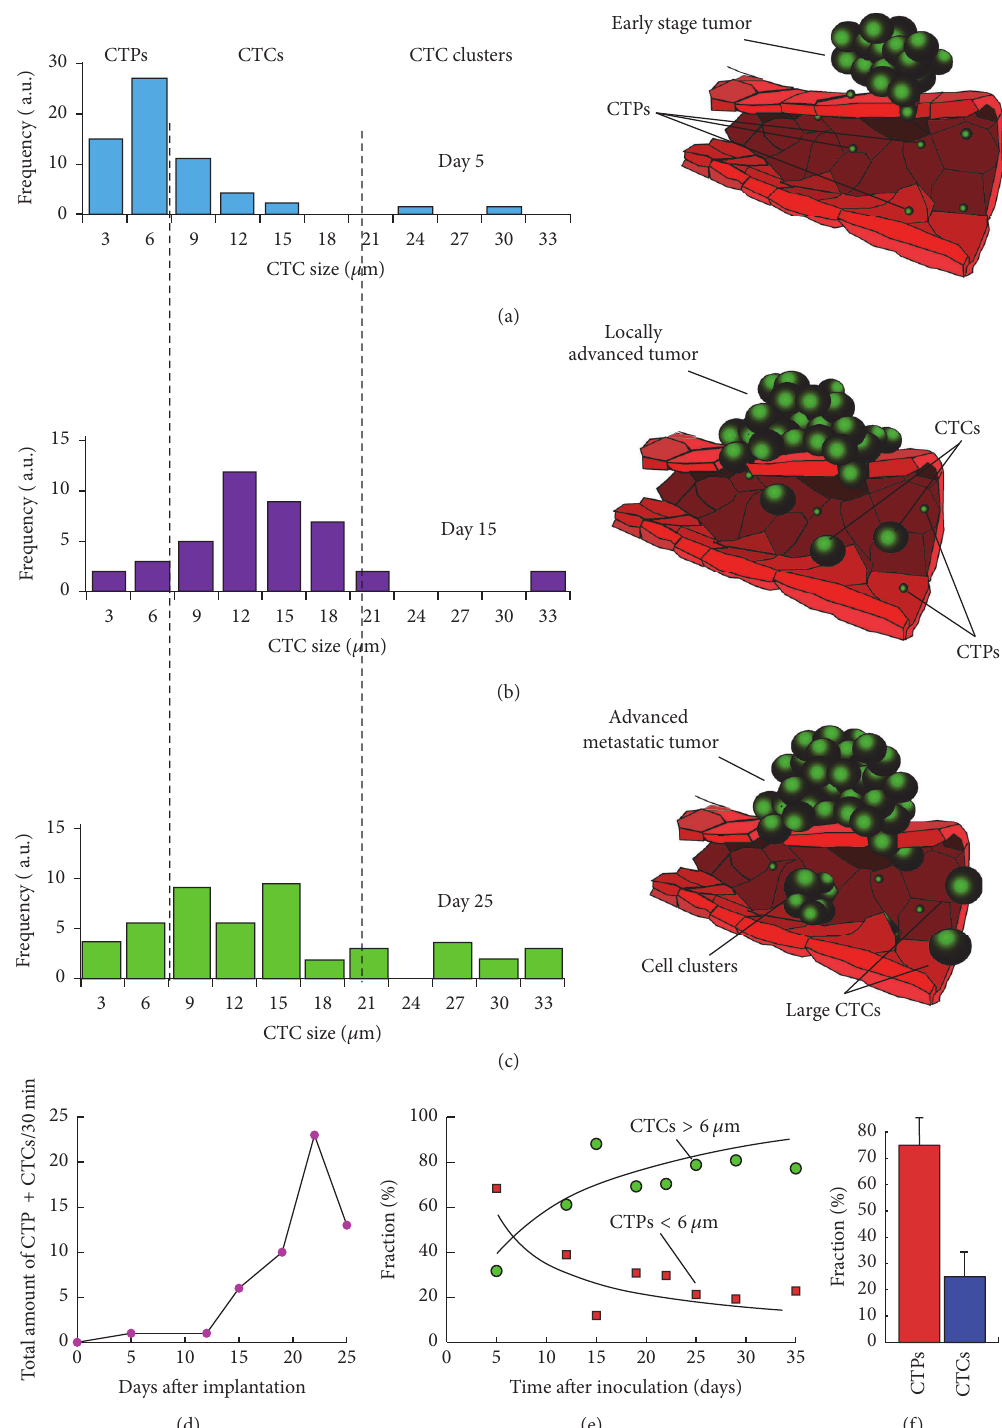
Figure 6: Monitoring of CTPs at early cancer stages. (a), (b), and (c) show histogram analysis of size frequencies during MTLn3 tumor development showing the prevalence of CTPs at day 5 and an increase in relative number of CTCs and clusters for days 15 and 25 (left) and thehypothesisandschematicofanearlystageappearanceofCTPsoverCTCsinbloodcirculation(right).(d)TypicalnumberofCTP/CTCsin circulation during tumor progression. (e) Proportion of CTPs (squares) and CTCs (circles) over time after tumor inoculation. (f) Proportion of CTPs and CTCs in carcinoma-bearing mouse at 3 days after tumor